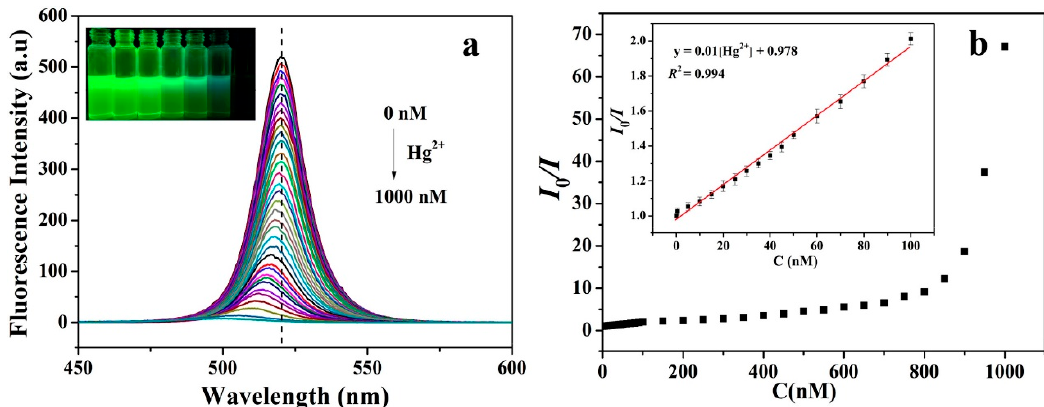
Figure 14. ( a ) Evolution of fluorescence spectra changes of CH 3 NH 3 PbBr 3 QDs upon the addition of different amounts of Hg 2+ . The concentration of Hg 2+ from top to bottom: 0–1000 nM. ( b ) Linear fitting curve of I 0 / I with respect to Hg 2+ concentration over the range of 0–100 nM (reproduced with the permission from reference [148]).